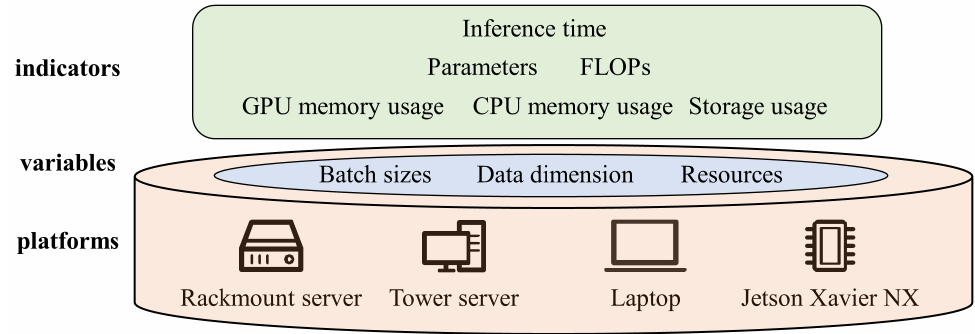
Figure 10. The framework for evaluating the complexity of deep learning